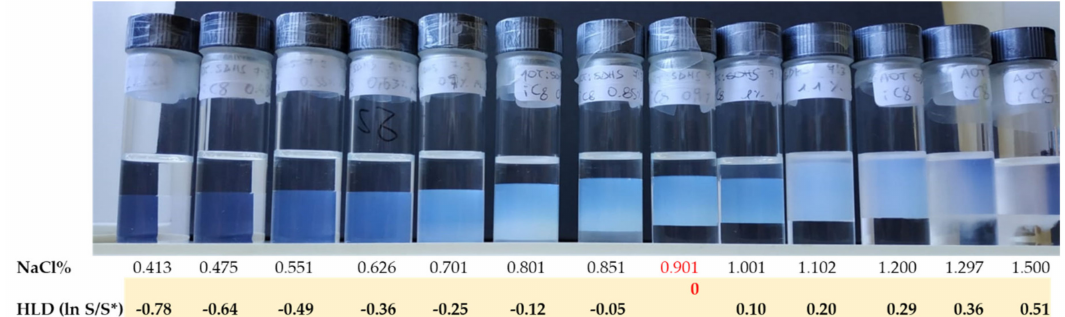
Figure 12. Example of salinity scan for a mix of sulfosuccinate surfactants in isooctane and